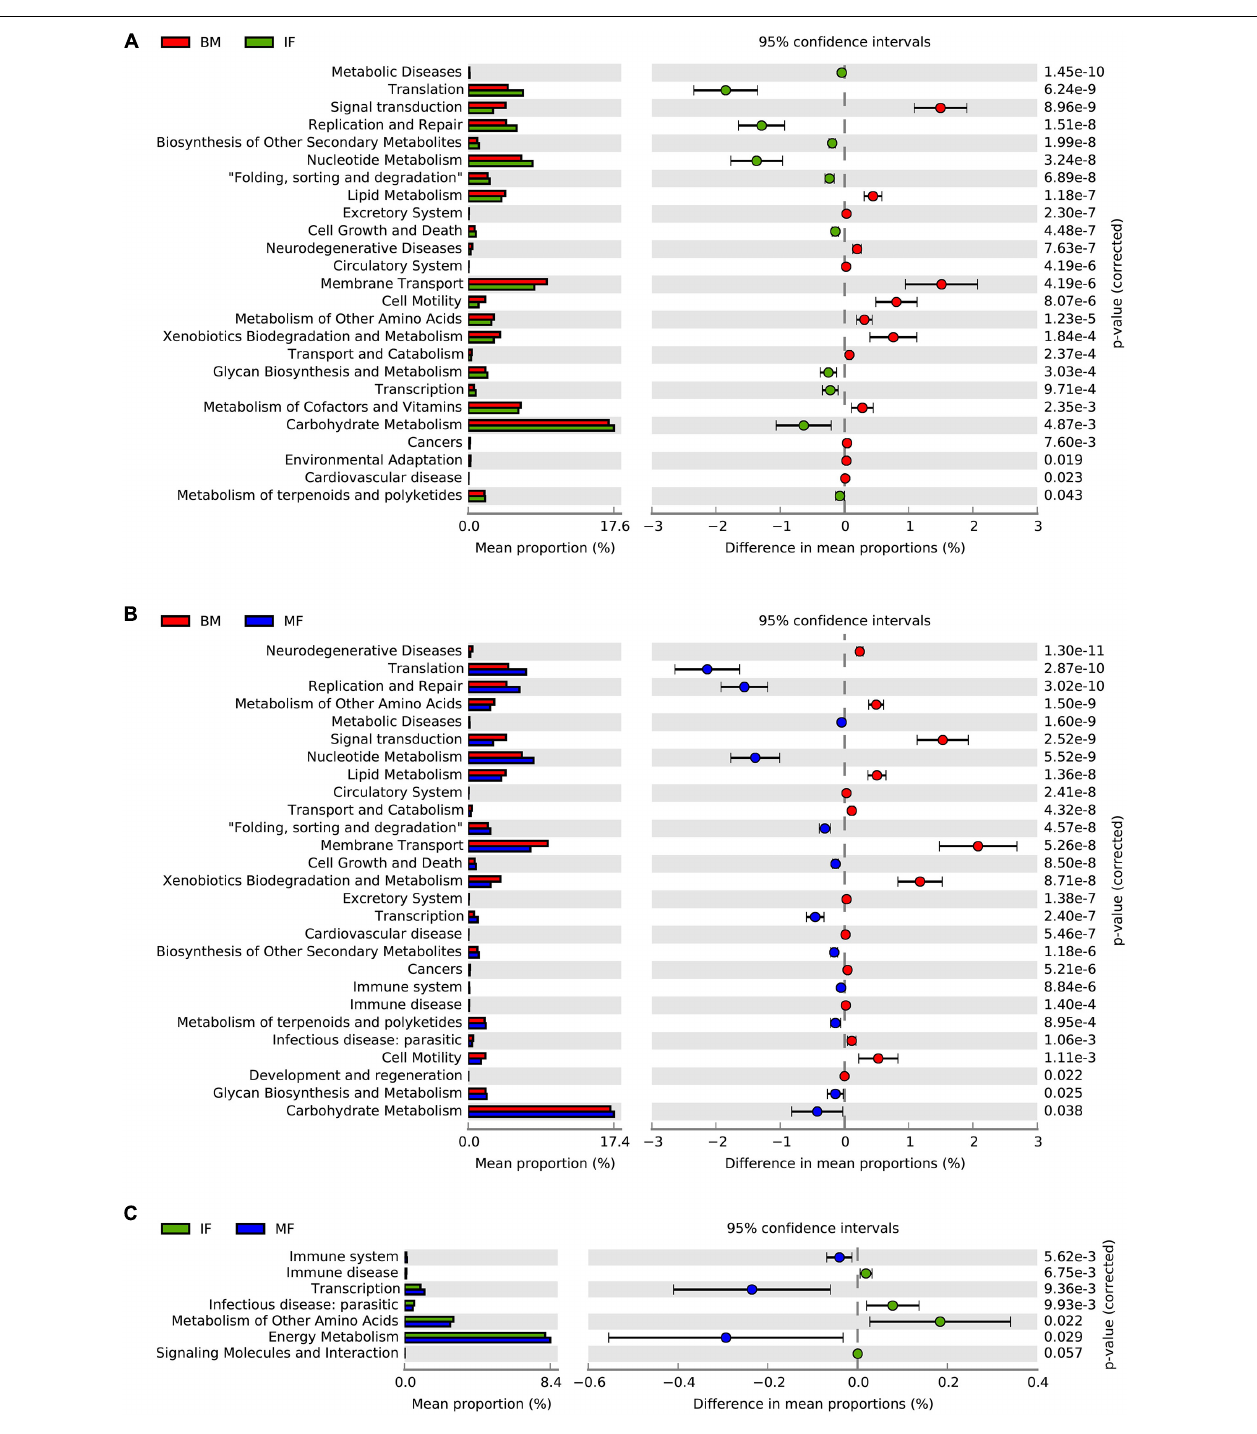
FIGURE 4 | PICURSt2 functions prediction of microbiota in human breast milk (BM), maternal feces (MF), and infant feces (IF). (A) Functional differences between BM group and IF group. (B) Functional differences between BM group and MF group. (C) Functional differences between IF group and MF group.